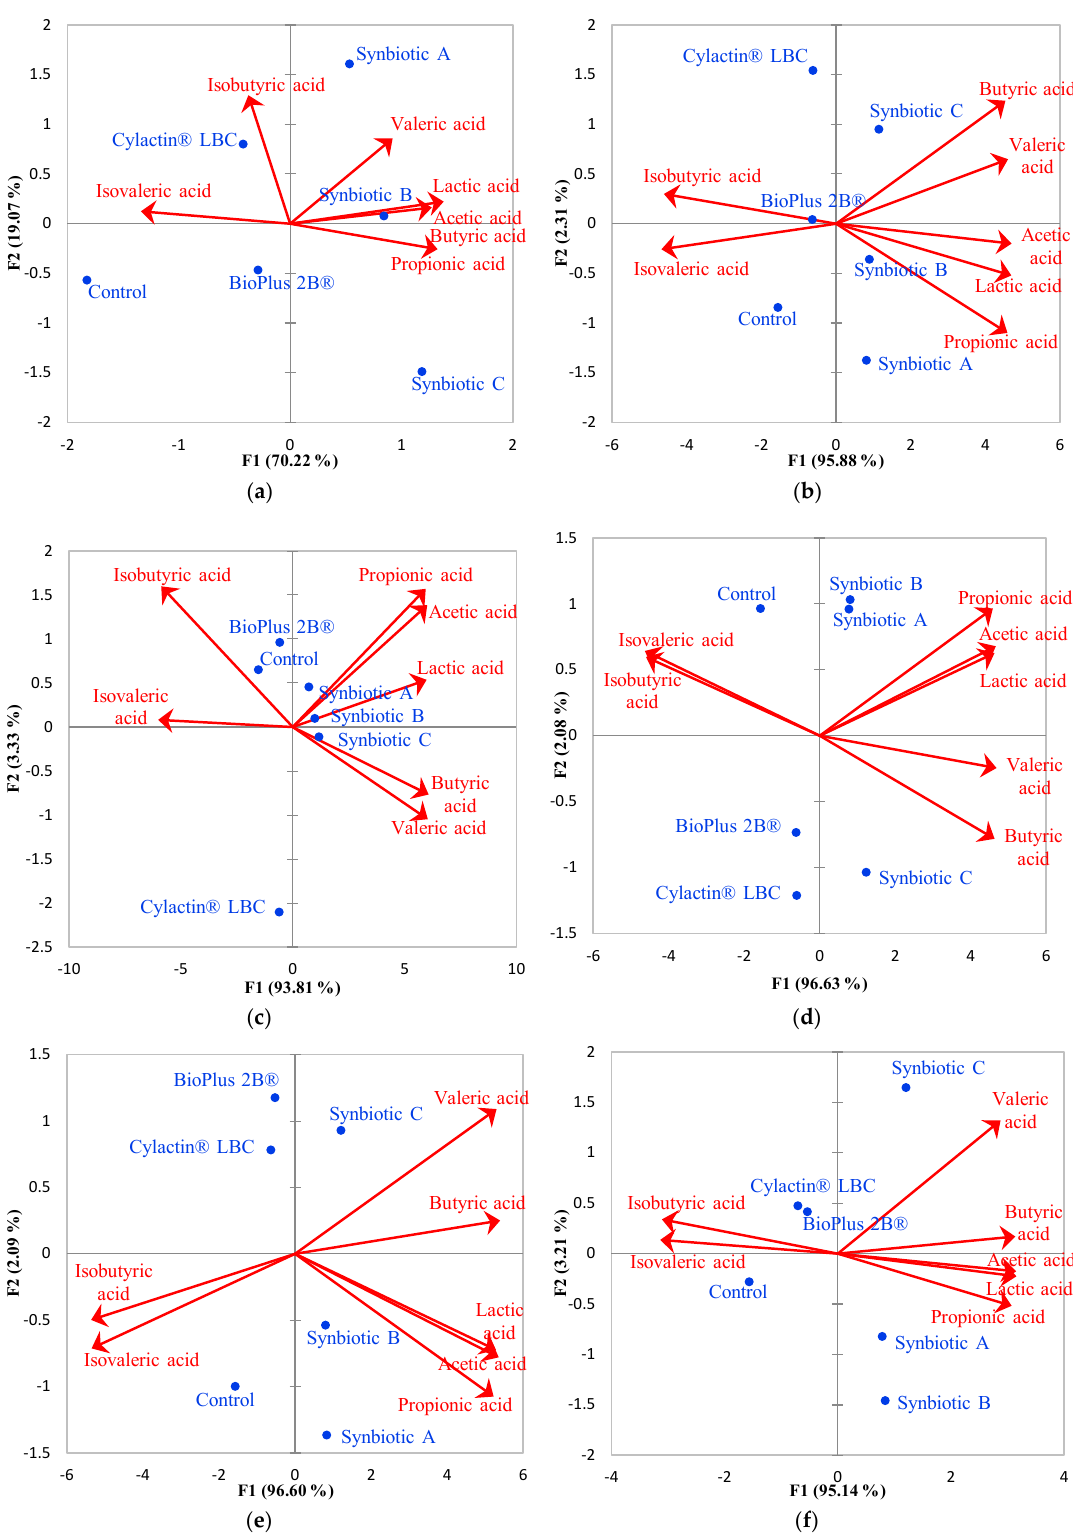
Figure 5. Correlation biplots display the PCA results of different preparations or its absence (blue dots), and their influence on lactate, SCFAs, and BCFAs synthesis and their concentrations (red vectors which represent variables) in pigs’ feces in different breeding stage: ( a ) 7th and ( b ) 28th day of life—piglets breastfed by sows; ( c ) 35th, ( d ) 68th, ( e ) 73rd, ( f ) and 165th day of life—feed additives administration to weaned piglets.